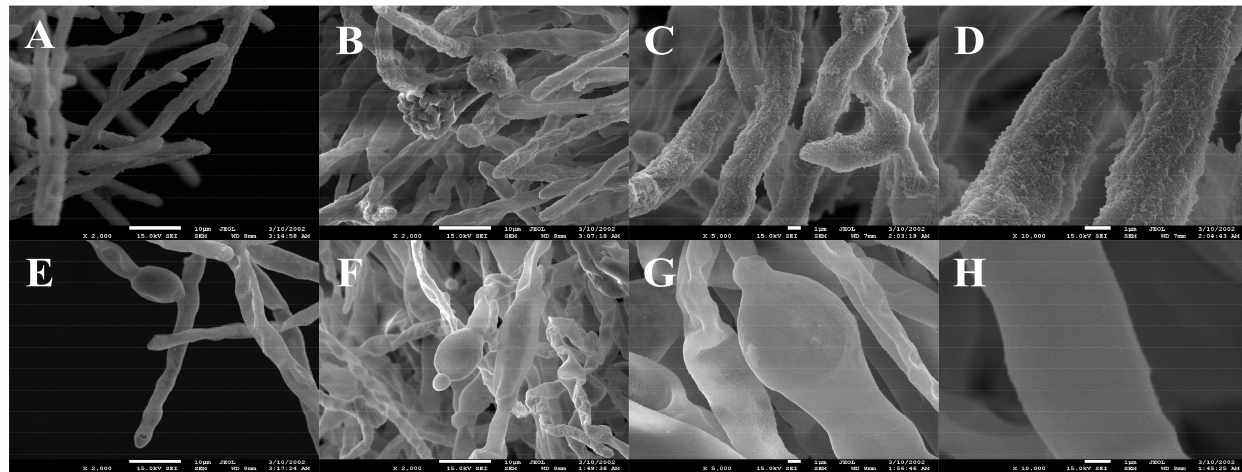
Figure 6. SEM of A. flavus growth without the presence of antagonistic substances (control: ( A – D )) and faced with LPs ( E – H ). The figures show: suppression of mycelial growth of A. flavus , the apex of the mycelium was broken ( E ); degenerative change in the morphology of the fungus hyphae ( F ); the mycelium was twisted, collapsed, and abnormally swollen ( G ); the mycelia was smooth and more swollen than the control group ( H